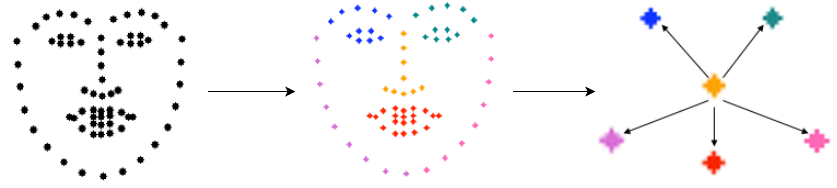
Figure 4. Diagram of face division. Landmarks of the same color are divided into a